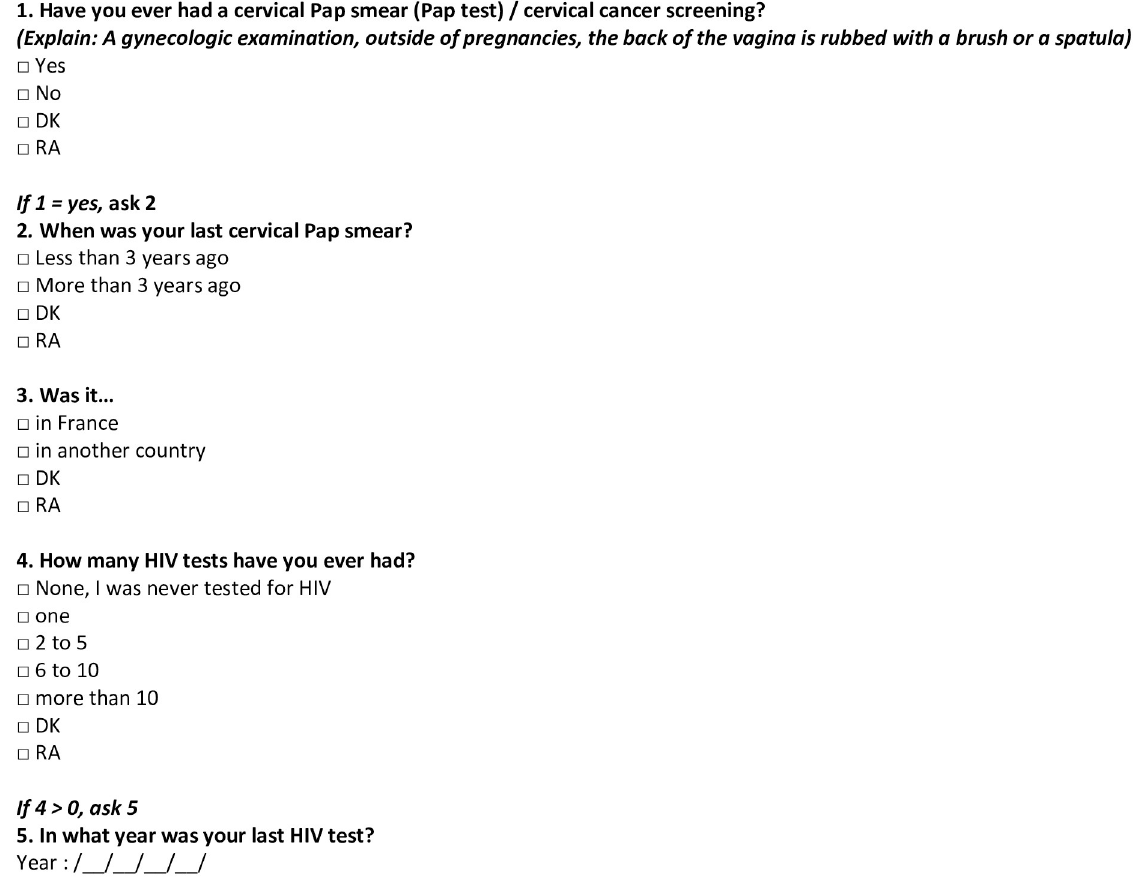
Fig 1. DSAFHIR study questionnaire—Variables of